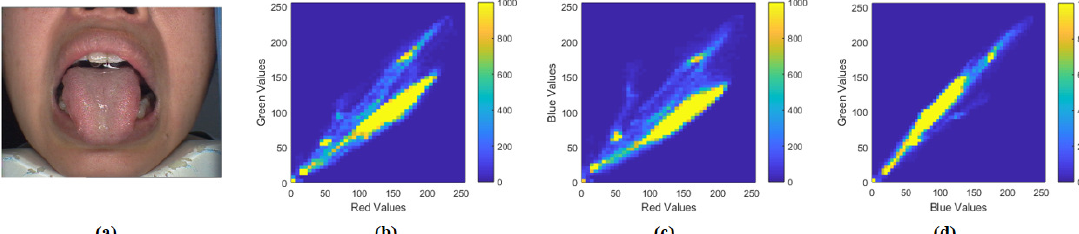
Figure 3. An example of color analysis to determine the dominant a color. The color bar beside the bivariate histograms show the relationship between the colors in the histogram and the pixel frequencies. ( a ) a sample from the dataset; ( b ) bivariate histogram of red vs. green; ( c ) bivariate histogram of red vs. blue, and ( d ) bivariate histogram of blue vs.